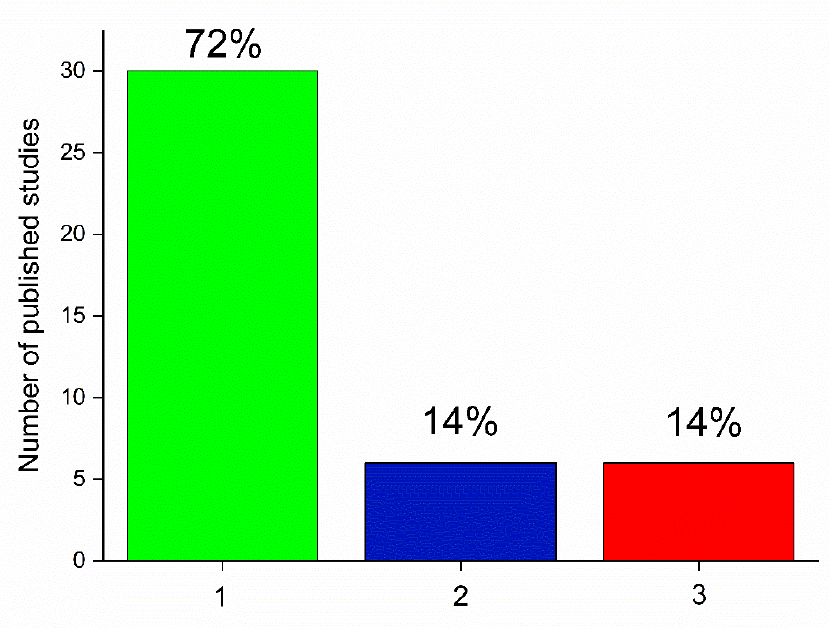
Figure 5. Types of luminophores used in photoconversion covers based on dyes (1), based on metal-containing nanoparticles (2), and based on nanoparticles containing rare earth elements (3)